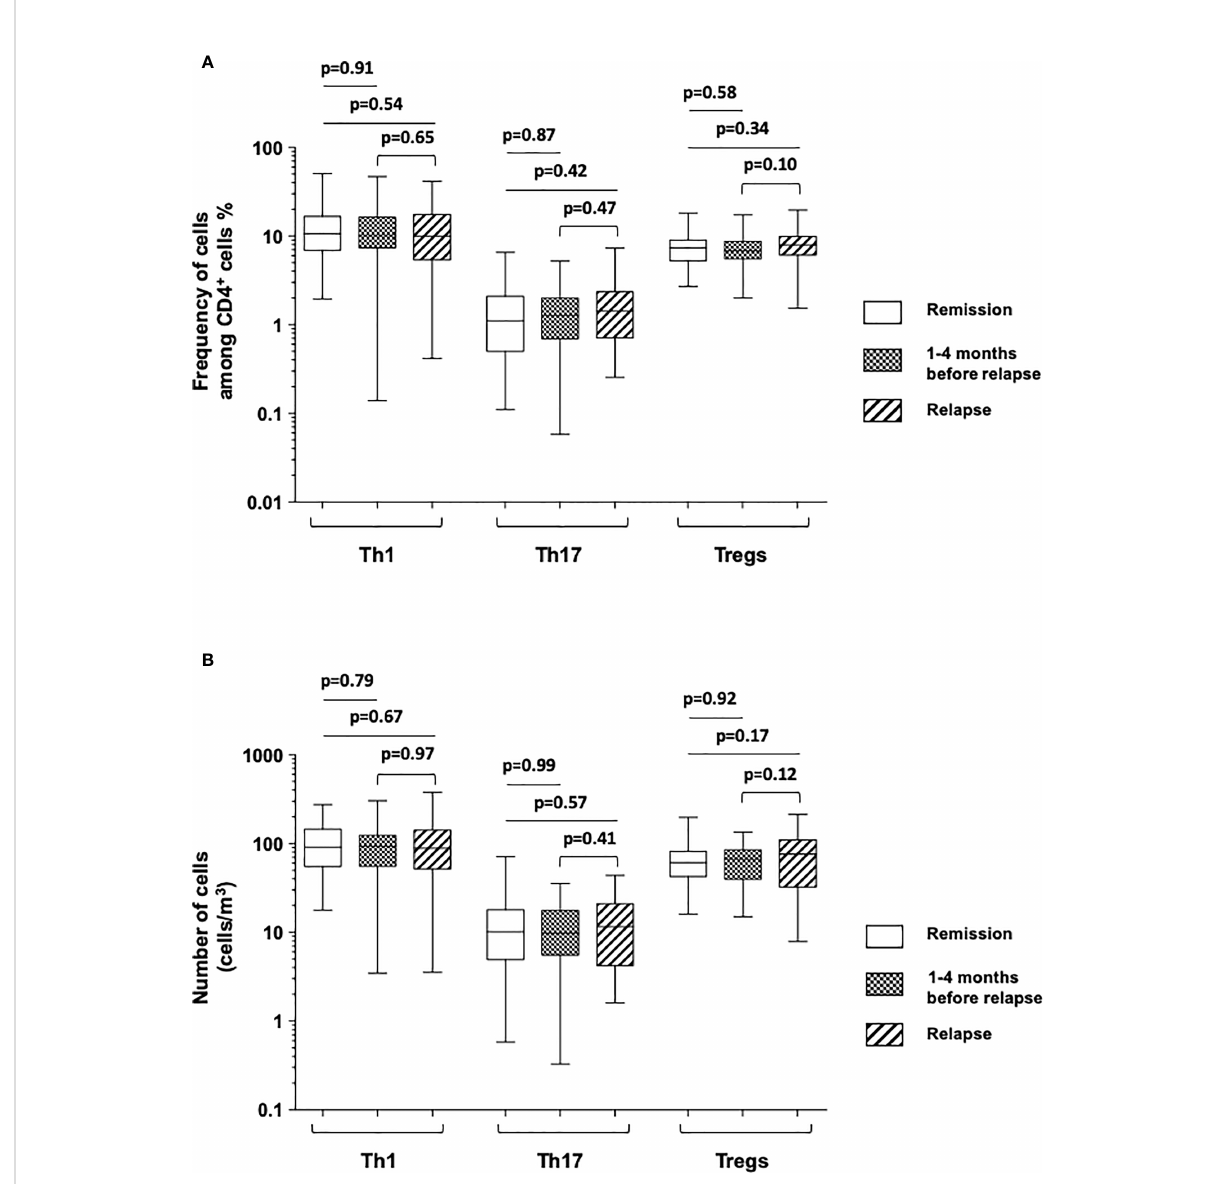
FIGURE 2 Comparison of the frequencies of cells among CD4 + T cells (A) and absolute number of cells [cells/mm (1)] (B) of Th1 (IFN g -expressing CD4 + T cells), Th17 (IL-17A-expressing CD4 + T cells), and Tregs (FOXP3 + -expressing CD4 + T cells) among Crohn ’ s disease patients who stayed in remission all throughout the follow-up (white), those who were in remission at the time of the measurement but who experienced a relapse during the following 1 – 4 months (boxed), and at the time of relapse in patients who relapsed (shaded). The box plots show the median, upper, and lower quartiles of the data; the whiskers indicate the 95% con fi dence interval of the